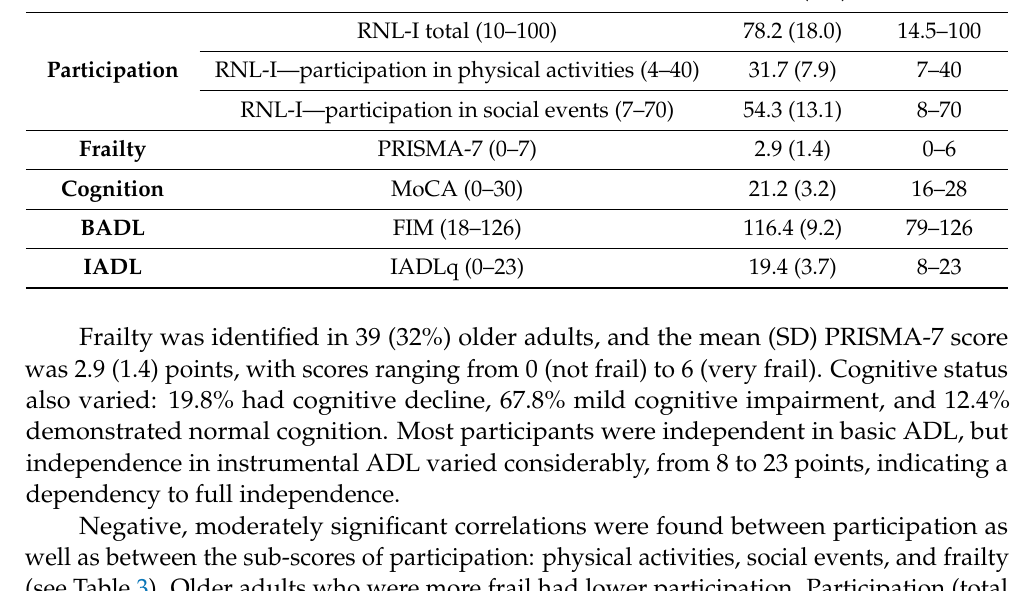
Table 2. Participation, frailty, cognition, and daily functioning of the sample (N = 121).